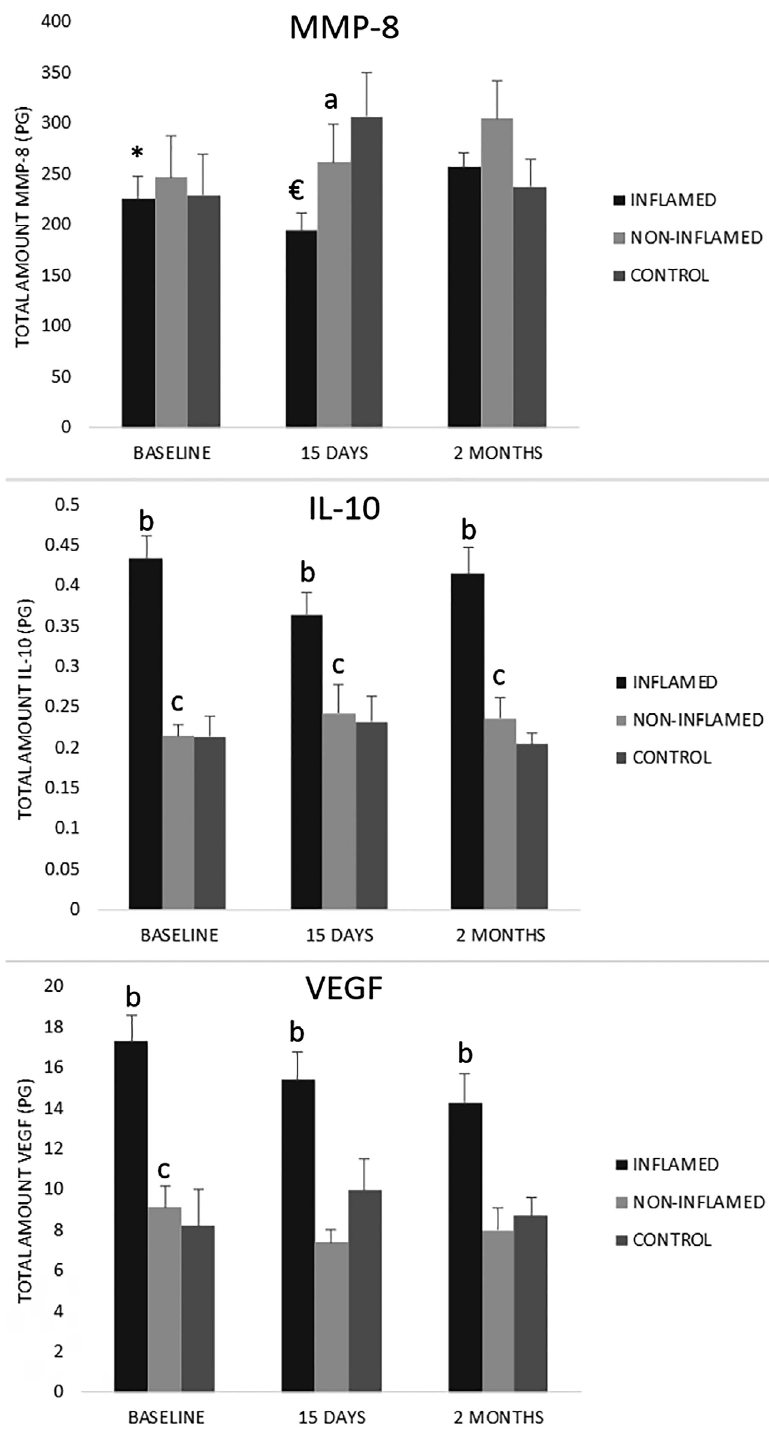
Figure 2- Total amount of VEGF, IL-10 and MMP-8 in gingival crevicular fluid of inflamed, non-inflamed and control sites, at baseline, 15 days and 2 months. Kruskal-Wallis test and ANOVA test. *: difference between inflamed sites at baseline and 2 months; €: difference between inflamed sites at 15 days and 2 months; a: difference between inflamed and non-inflamed sites at 15 days; b: difference between inflamed and control sites; c: difference between non-inflamed and control sites; VEGF: Vascular endothelial growth factor; IL-10: Interleukin-10; MMP-8: Matrix